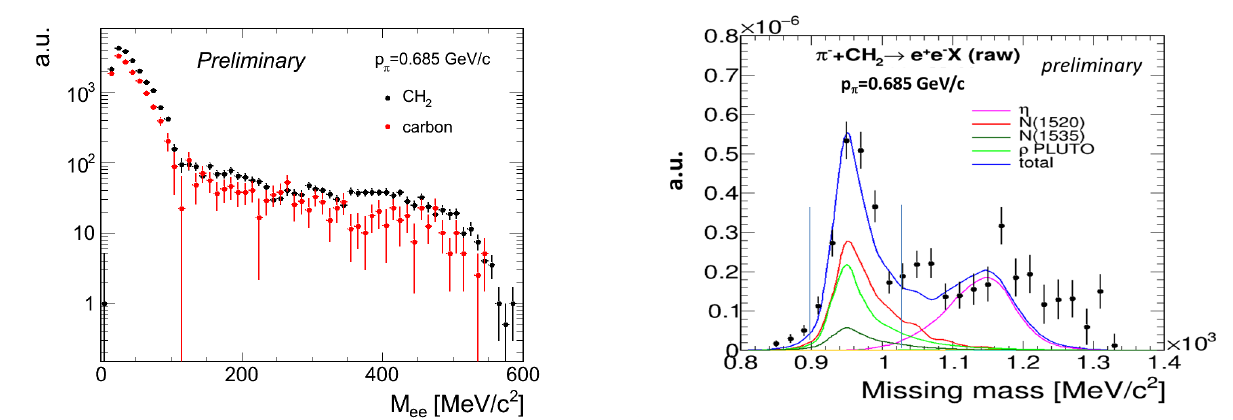
Figure 4. Distribution of the missing mass of e + e − events with invariant mass larger than 120 MeV / c 2 . The results of the simula- tion (total shown as a blue curve) including the η (pink), N(1520) Dalitz decay (red), N(1535) Dalitz decay (dark green), ρ (light green) are compared to the simulation showing the di ff erent com- ponents.